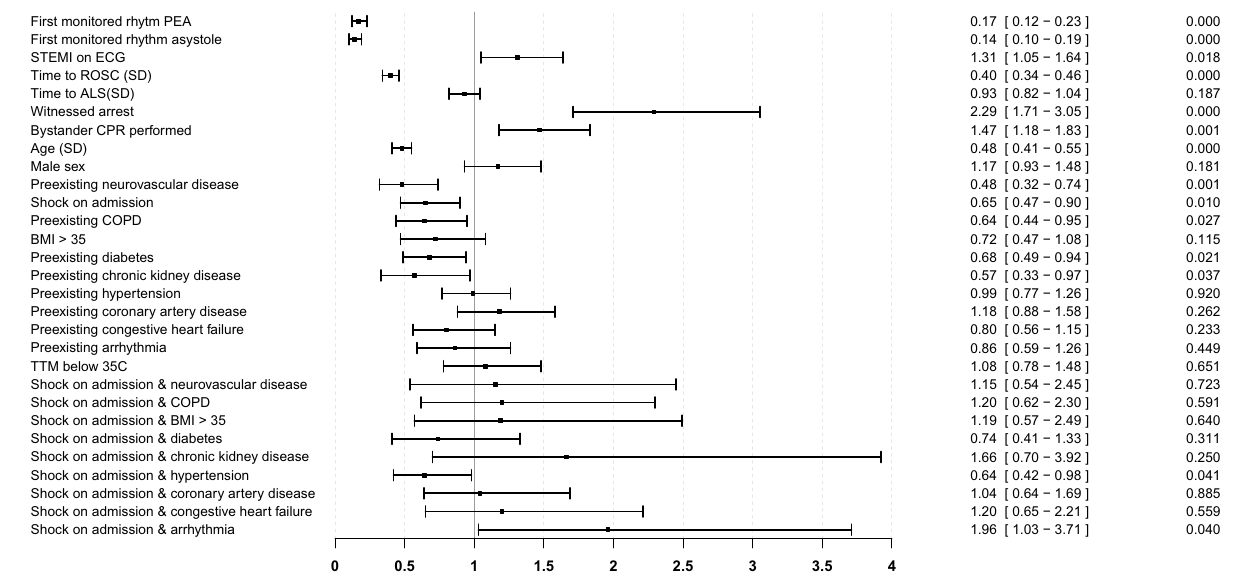
Figure 3. Association with good neurological outcome at hospital discharge in subgroup analysis. Forest plot illustrating the odds ratios for Cerebral Performance Category 1–2, in a multivariate generalized additive methods model. Analysis was performed in a subgroup of patients with linear continuous explanatory variables, aged 42–92 years, with time to ROSC 9–87 min. The reference category for first monitored rhythm is shockable rhythm (Ventricular fibrillation or ventricular tachycardia). Age (years) and time to ROSC (minutes) have been transformed to normality by ordered quantiles, time to ALS has been square root transformed. After transformation, the variables have been scaled to standard deviations and centered. Interaction between circulatory shock and preexisting comorbidities are included in the model. Point estimates are presented as odds ratios (OR) with 95% confidence intervals. PEA Pulseless electrical activity; STEMI ST-Elevation myocardial infarction; ECG Electrocardiogram; ROSC Return of spontaneous circulation; CPR Cardiopulmonary resuscitation; SD Standard deviation; COPD Chronic pulmonary obstructive disease; BMI Body mass index; TTM Targeted temperature